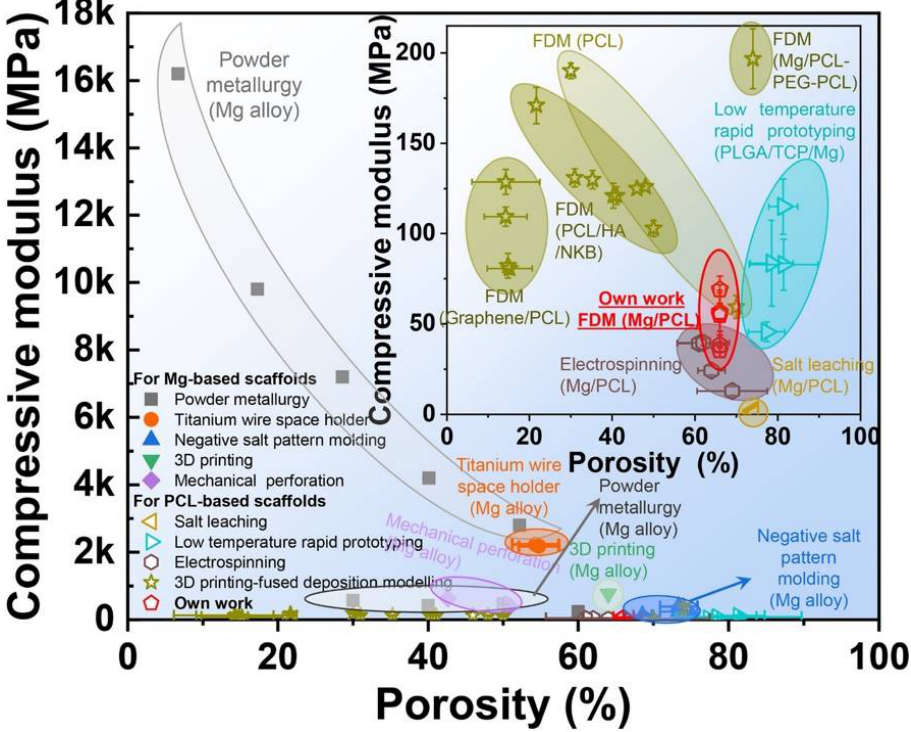
Figure 2. The compressive modulus of Mg-based and PCL-based scaffolds. Figure from [53].